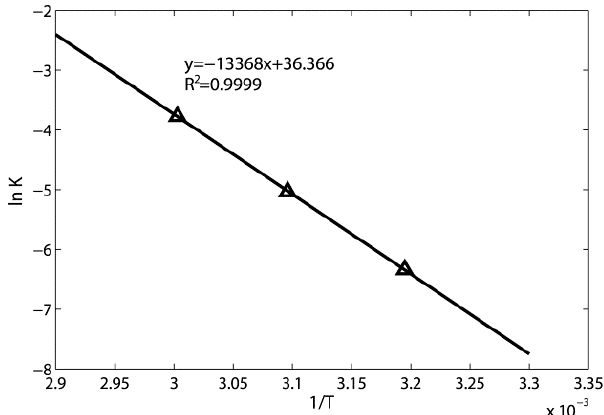
Figure 8. The Van’t Hoff plot for equilibrium constant of silica gel thermal desorption.